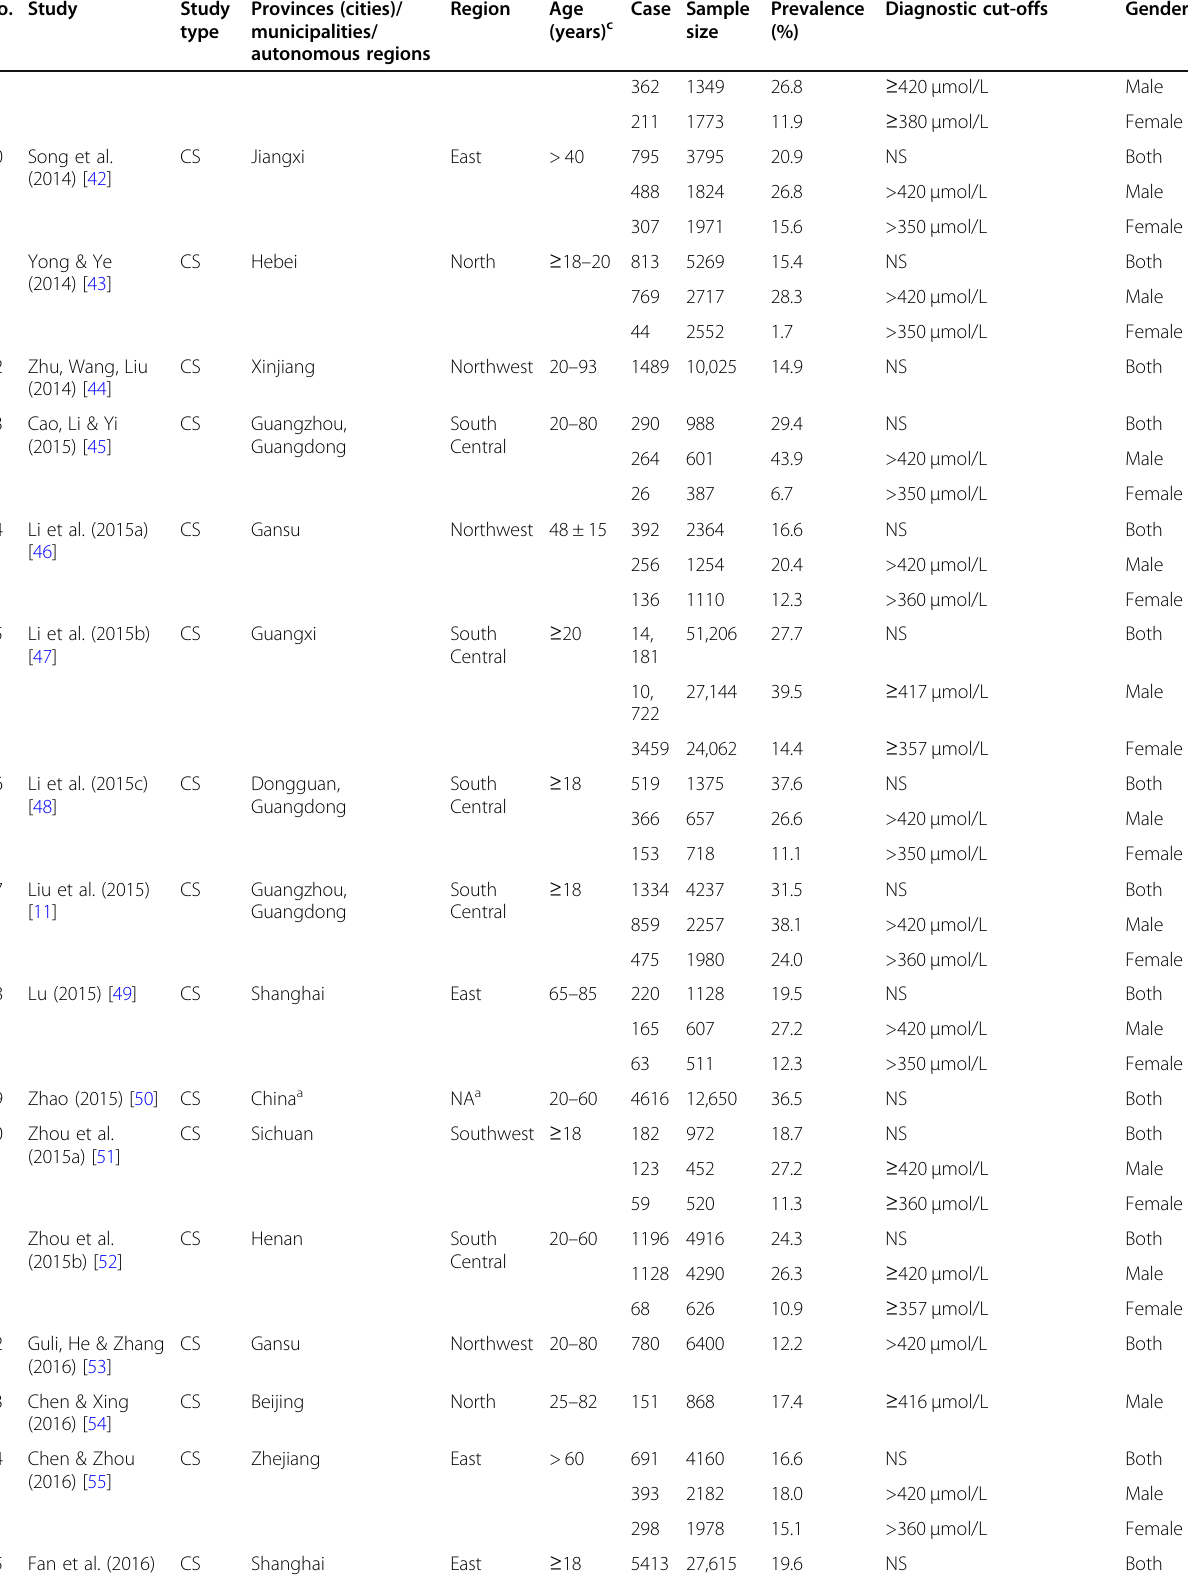
Table 1 Characteristics of the included studies in the systematic review and meta-analysis (Continued) No.